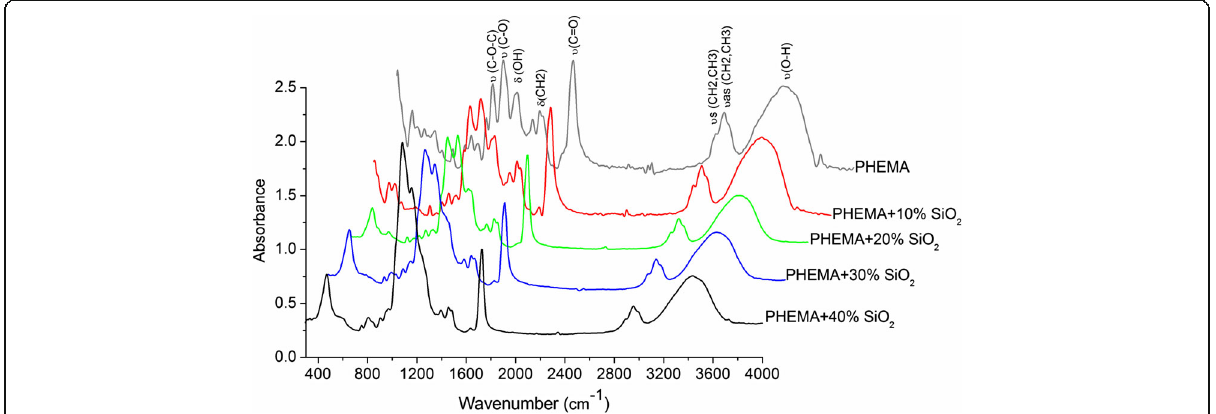
Fig. 4 IR spectra of PHEMA/nanosilica composites (series No 13)